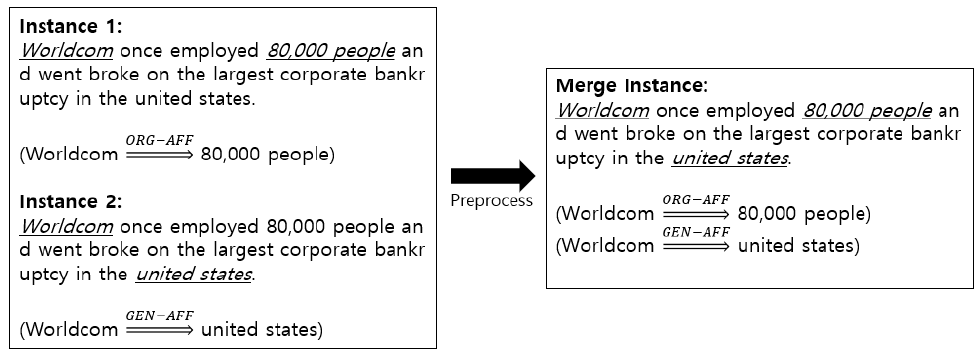
Figure 4. ACE-2005 data preprocess. ORG-AFF: organization-affiliation; GEN-AFF: general entity-affiliation.